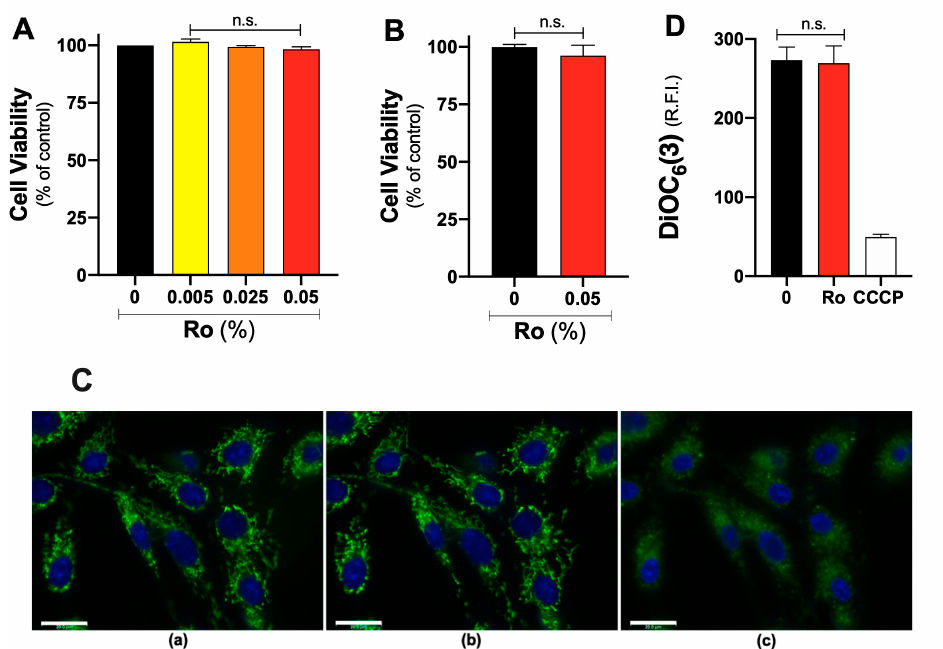
Figure 3. Absence of cytotoxicity of glycolic extract of Rosmarinus officinalis ( Ro ). ( A ) Viability of BRL 3A cells incubated with Ro (0 to 0.05%) for 24 h was estimated with MTT ( A ) and trypan blue ( B ) assays. The effects of Ro on cell viability were calculated in relation to control (absence of Ro ), considered 100%. ( C ) Representative images of the mitochondrial membrane potential estimated by fluorescence microscopy using DiOC 6 (3). Cells were loaded with dyes, and fluorescence emission was acquired before and after 0.05% Ro addition. The uncoupler CCCP (10 µ M) was used as positive control (see Methods for details). Scale bars (20 µ m) ( D ) Relative quantification of DiOC 6 (3) fluorescence emission (L5 channel) considering the replicates. In ( A , B ) data are expressed as percentages of viable cells (mean ± SD) calculated in relation to control (i.e., without Ro ), considered as 100%. Statistically non-significant (n.s.), considering p < 0.05.